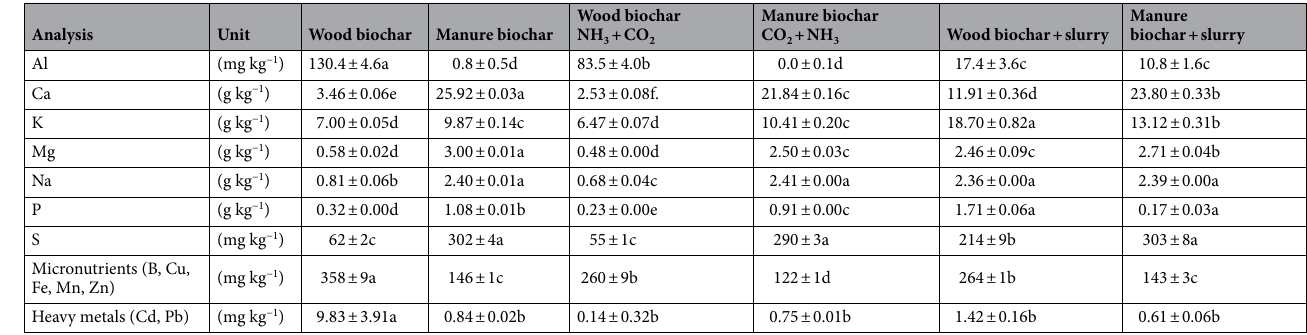
Table 3. Plant-available nutrients in amendments, extracted with Mehlich III ± the standard deviation. Letters indicate significant differences between amendments using a one-way anova (p < 0.05; n = 3).